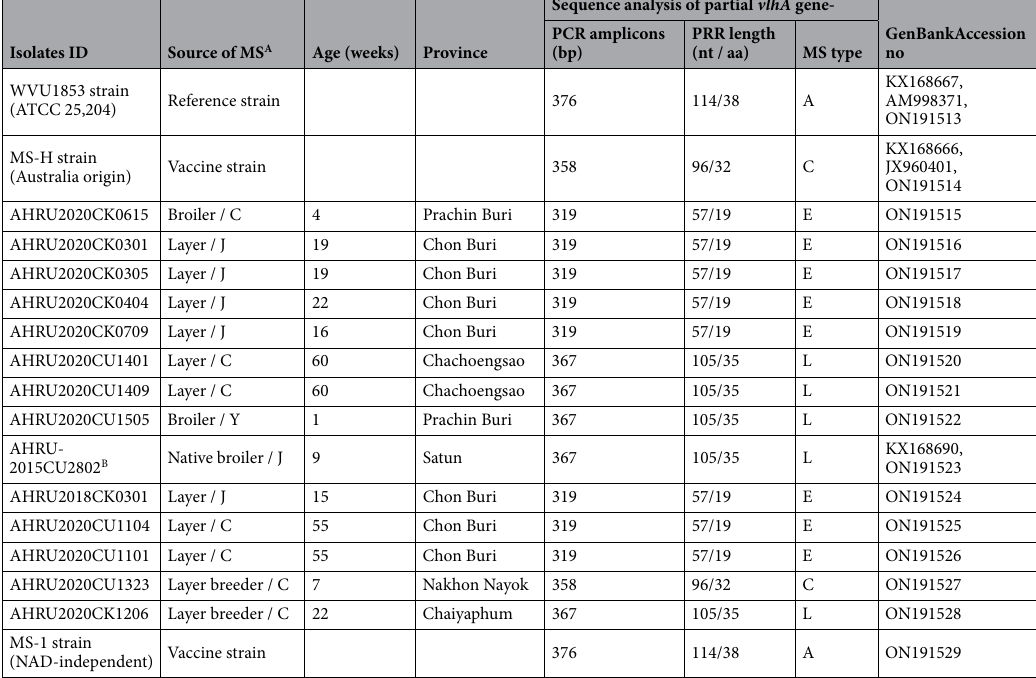
Table 2. Information and molecular characteristic details of M. synoviae isolates and strains used in this study. A Abbreviations C, J, and Y represented the swab samples from choanal cleft, synovial fluid, and yolk sac. B AHRU2015CU2802 is a Thai M. synoviae field strain isolated in 2015.